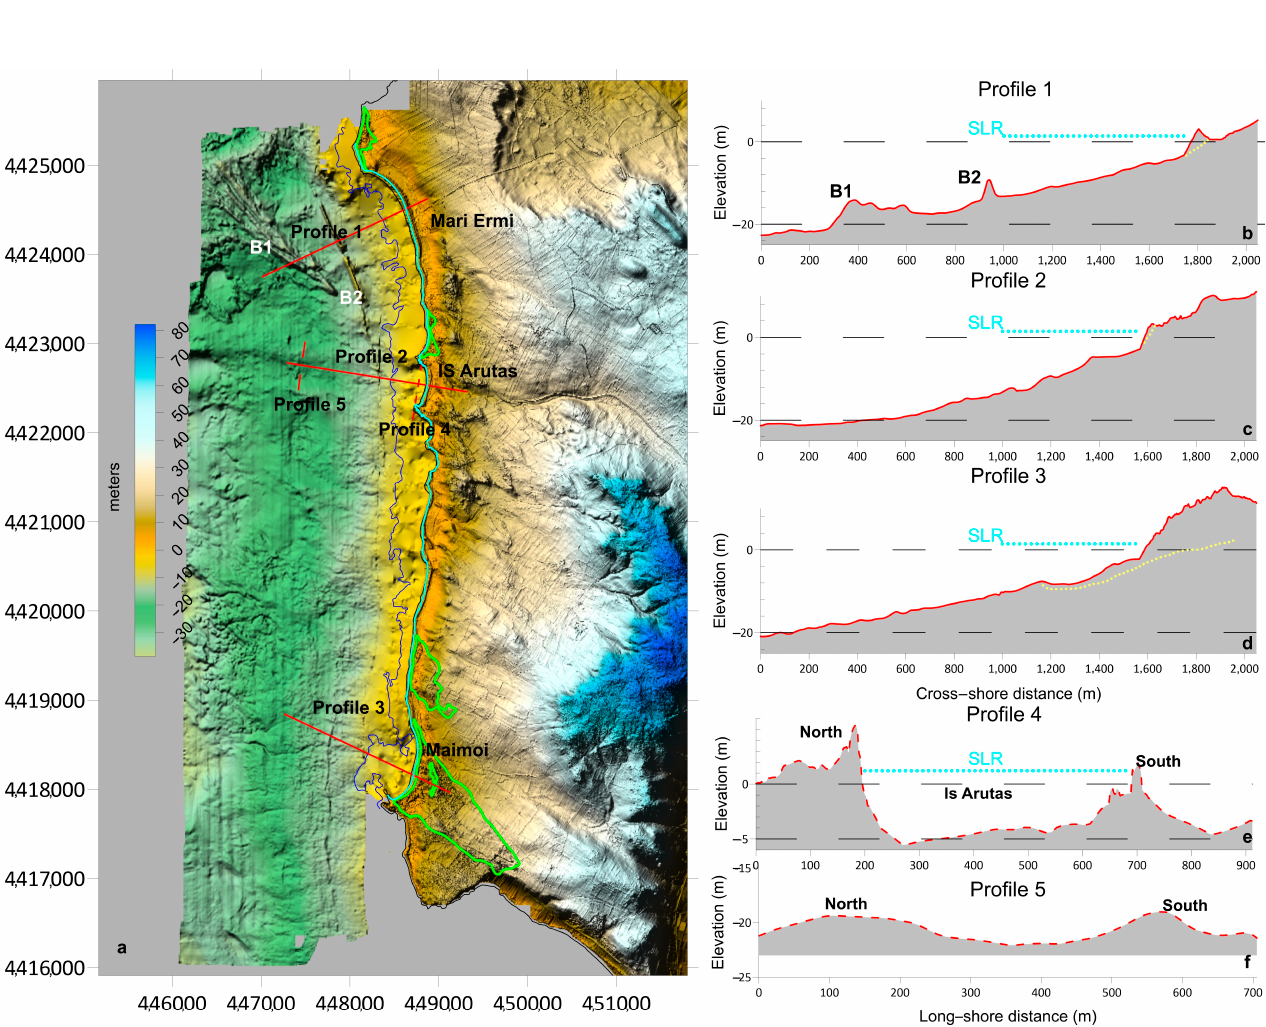
Figure 9. ( a ) The digital terrain model obtained by the merging of the MBES data, SBES data and lidar Data. Lidar data are available from (http://webgis2.regione.sardegna.it/catalogodati/card.jsp?uuid=R_SARDEG:BFPNM, accessed on 29 November 2019), in green, the boundaries of the dune field along the studied area; in cyan, the foresee of the maximum level of the sea, as reported by Antonioli et al., 2017 [55]. In red, the location of the profile realized by using Surfer Golden Software; ( b ) the cross-shore profile along Mari Ermi, ( c ) the cross-shore profile along Is Arutas; ( d ) the cross-shore profile along Maimoi; the dashed yellow line represents the lower beach level; ( e ) the longshore profile along Is Arutas; and ( f ) the longshore profile along the inner shelf fronting Is Arutas beach.